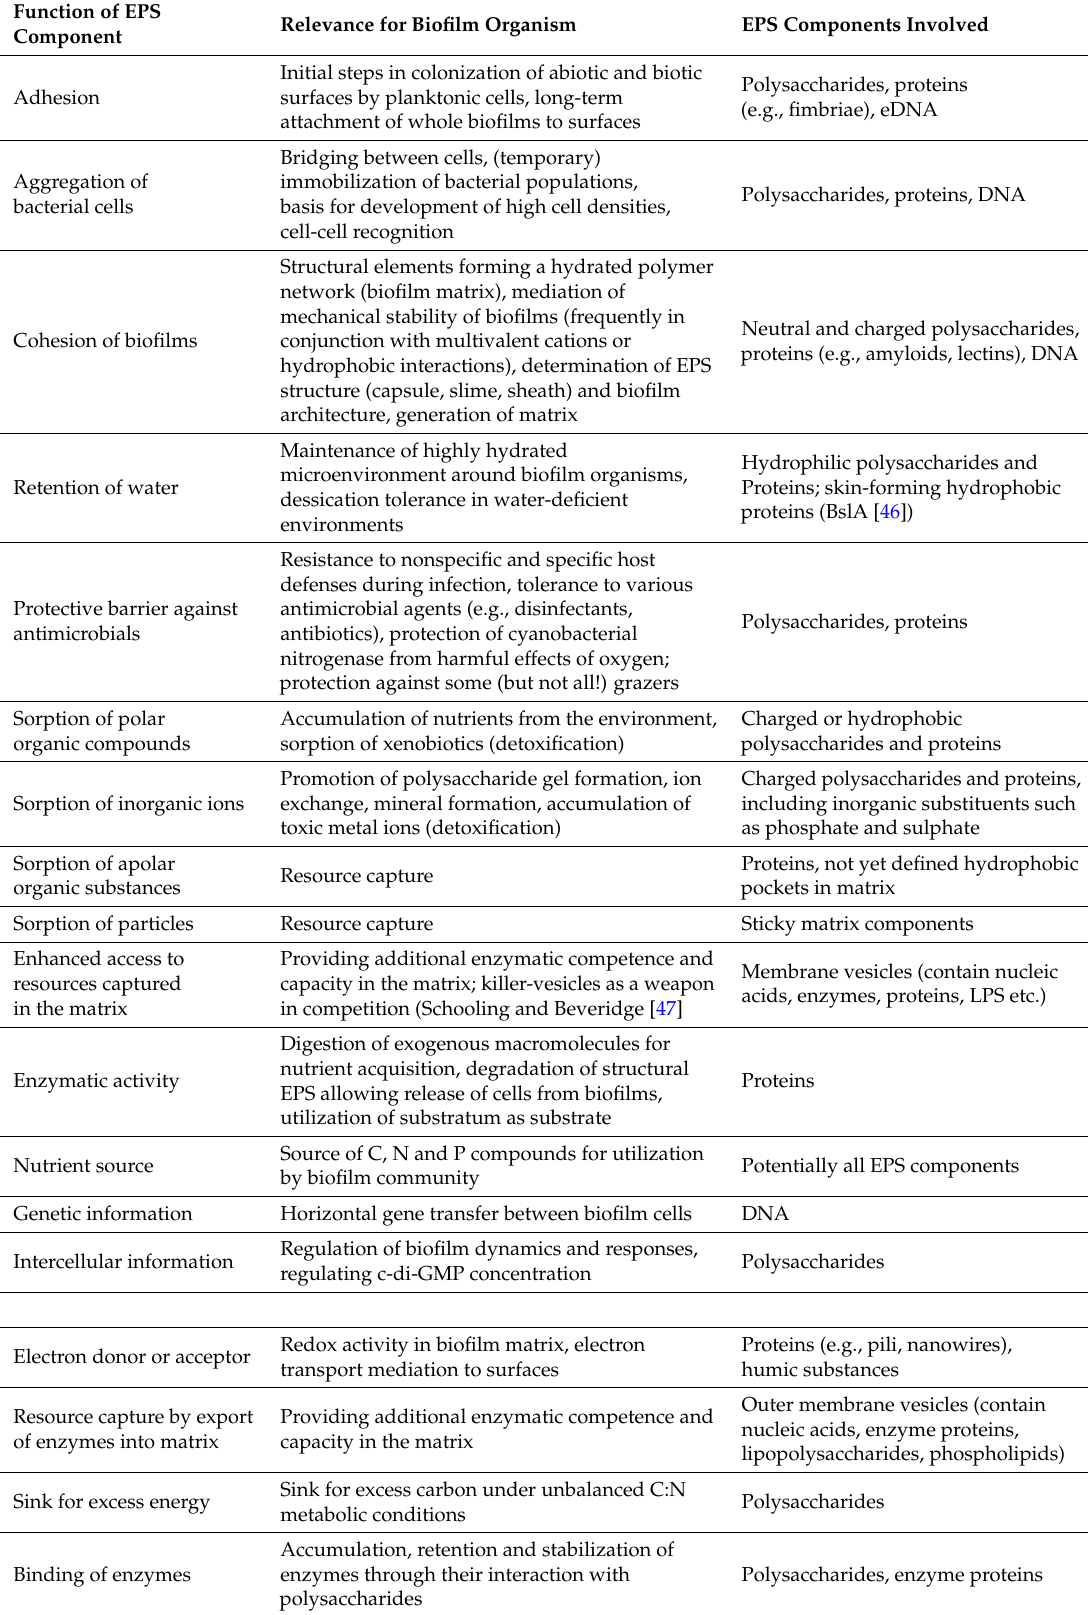
Table 1. Functions of extracellular polymeric substances (EPS) components (after [19], with permission). Function of EPS